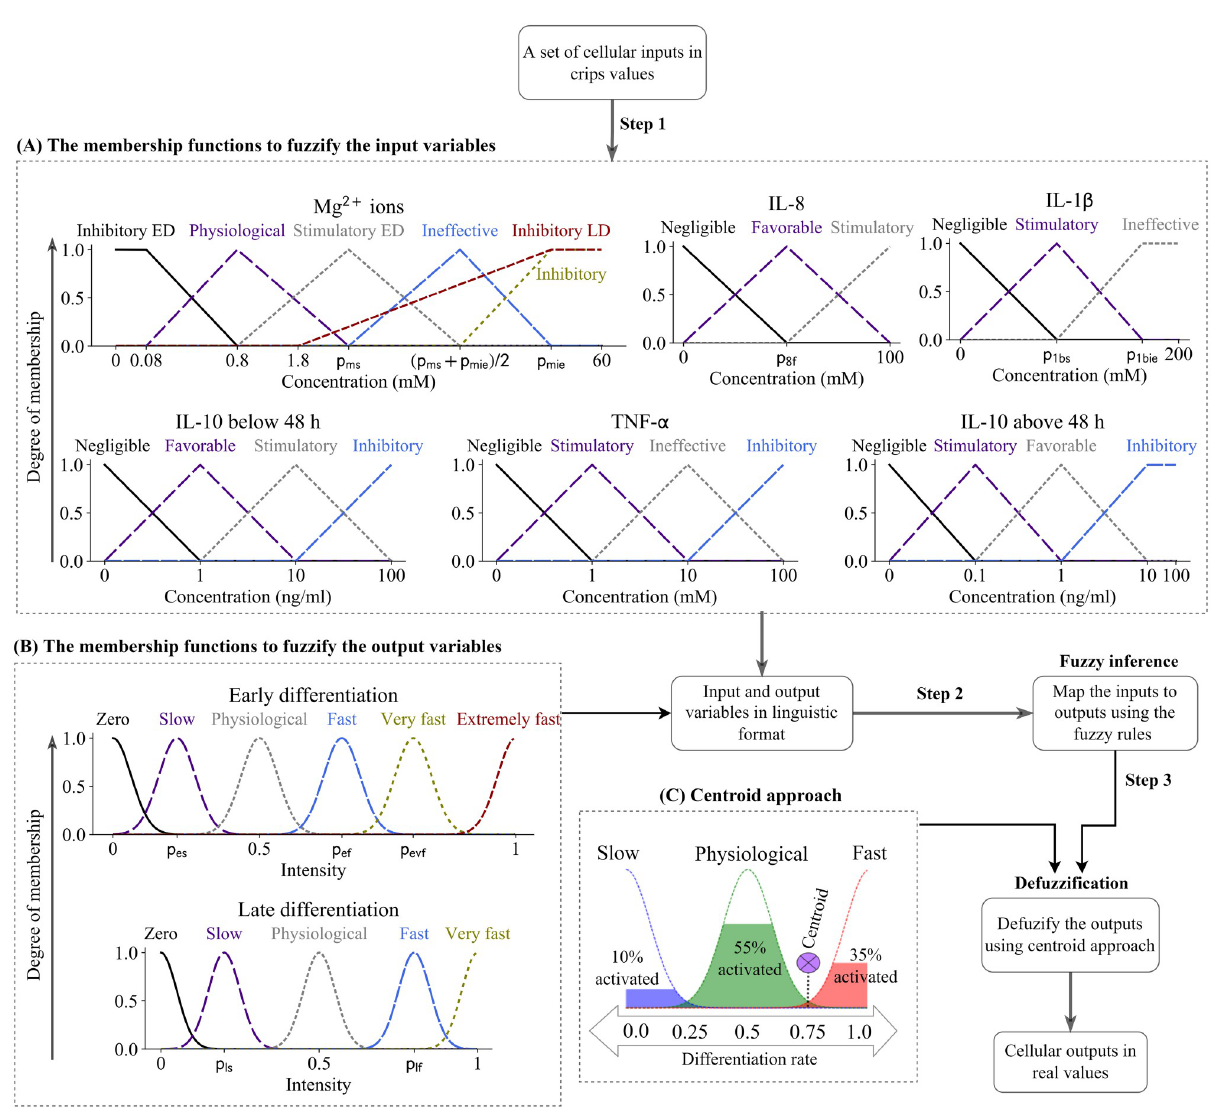
Fig 10. The complete flow of the implemented FL controller in this study. In step 1, the cellular inputs are transformed to linguistic variables using the membership functions given in (A). A set of triangular and trapezoid memberships functions are used during this fuzzification process. Similarly, cellular outputs of early and late differentiation rates are defined in linguistic formats using the membership functions given in (B). A set of Gaussian membership functions are used for this purpose. In step 2, the FL controller receives the cellular inputs and calculates the cellular outputs, both in linguistic form. In step 3, the outputs are defuzzified and converted into crisp, real values using the centroid approach (C). The terms ‘ED’ and ‘LD’ stand for early differentiation and late differentiation, respectively.